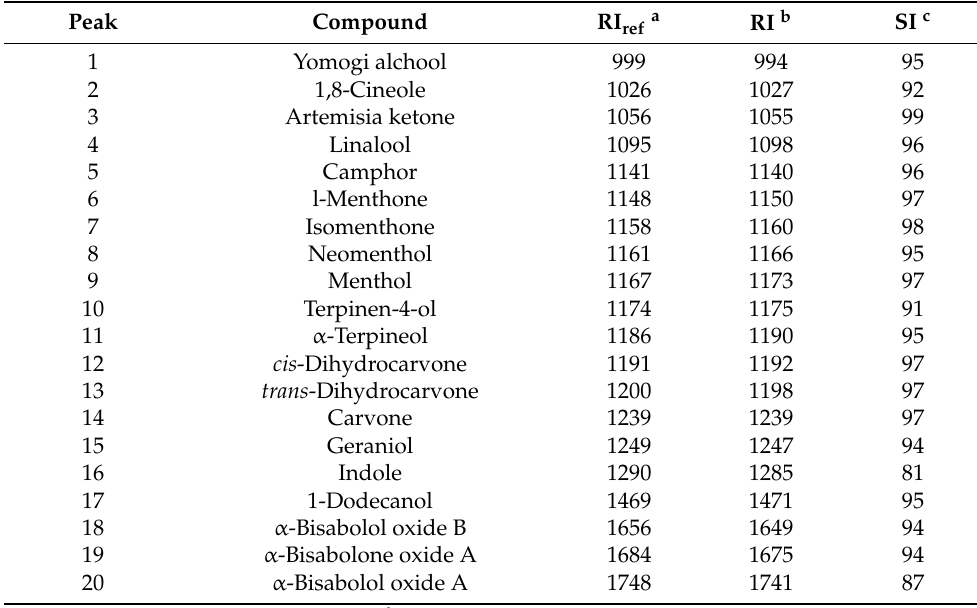
Table 1. Major volatiles identified in the experimental materials by SPME-GC–MS